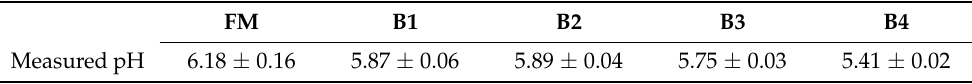
Table 7. pH variations before/after spicing the minced meat (before